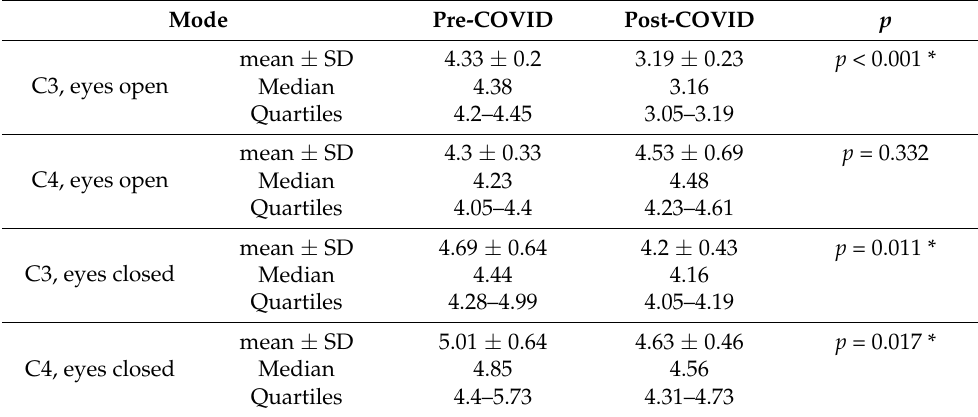
Table 4. The results of the SMR waves examination (waves from C3, C4